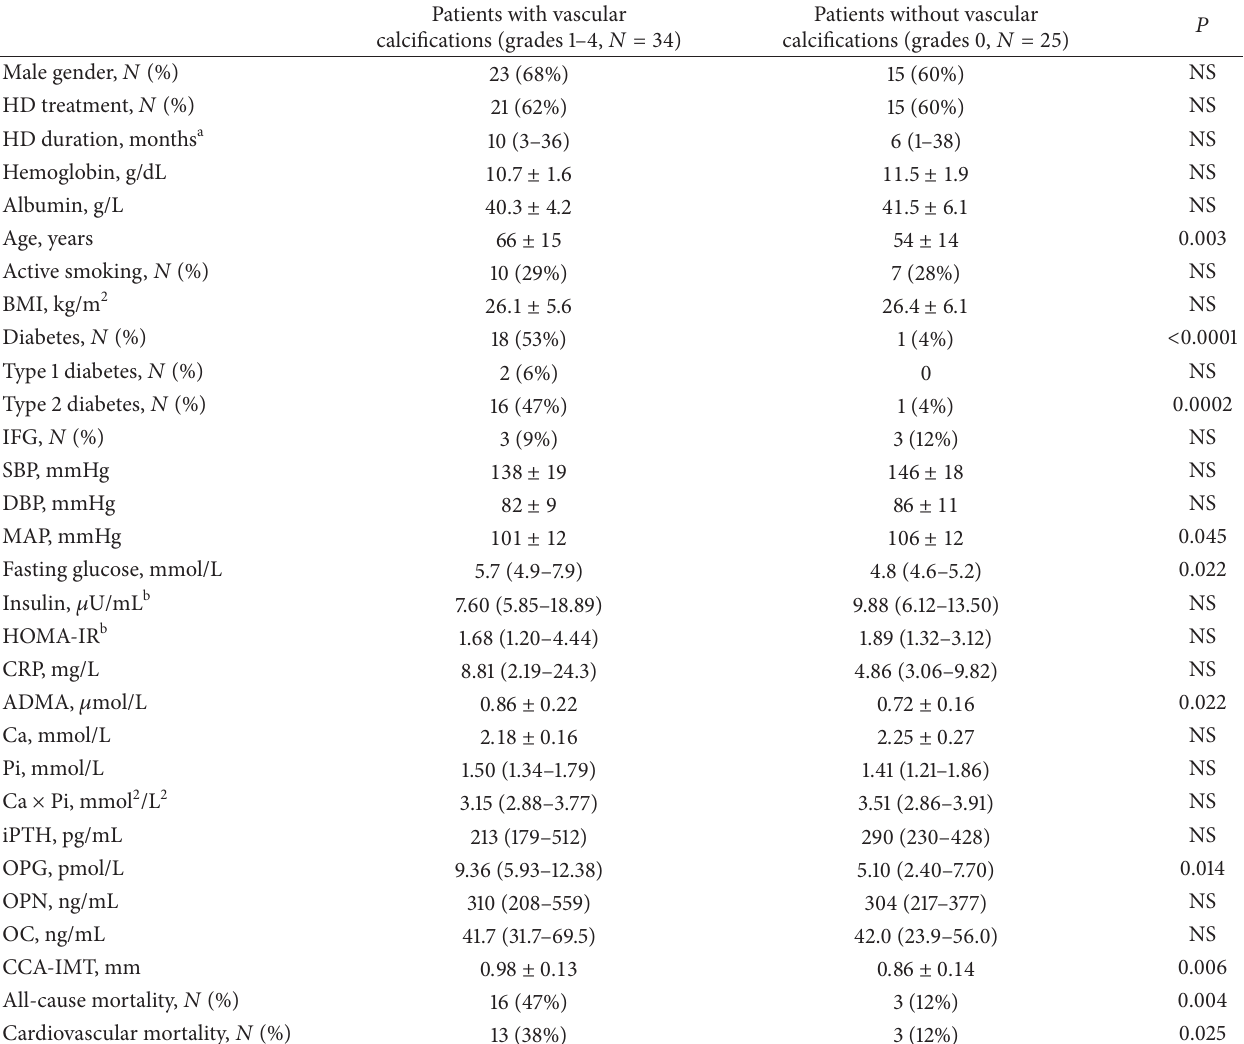
Table 1: Differences in clinical parameters between patients with and without vascular calcifications as assessed by alizarin red staining of the radial